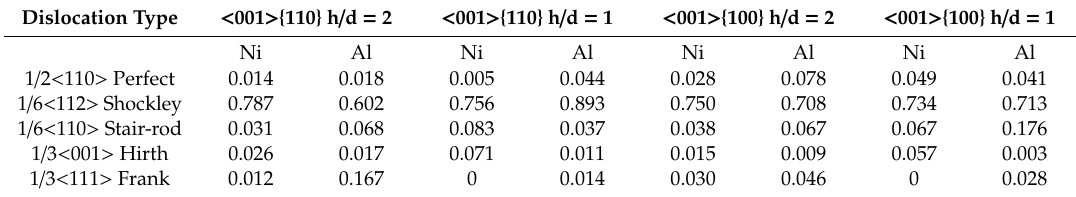
Table 1. Fractions of di ff erent dislocations in Ni and Al samples subjected to 22% strain. Dislocation